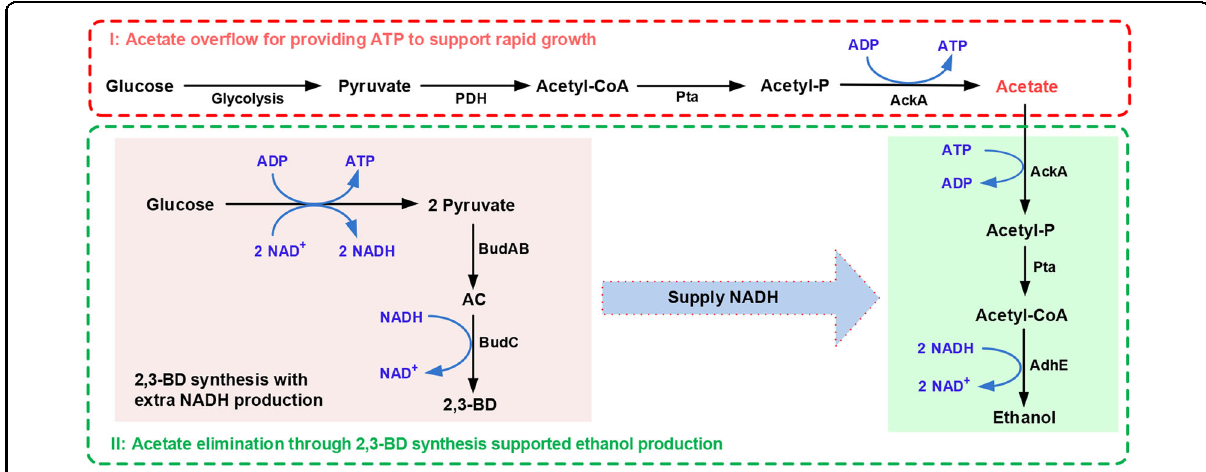
Fig. 6 Mechanism of acetate-induced 2,3-BD biosynthesis supports ethanol production for acetate elimination. PDH, pyruvate dehydrogenase; Pta, phosphate acetyltransferase; AckA, acetate kinase; AdhE, bifunctional acetaldehyde/ethanol dehydrogenase; BudR, lysR family regulatory protein; BudA, α -acetolactate decarboxylase; BudB, α -acetolactate synthase; BudC, 2,3-butanediol dehydrogenase; Acetyl-P, acetyl